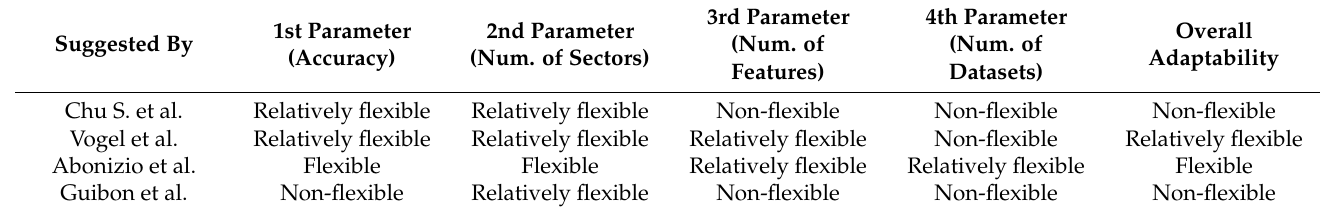
Table 11. Adaptability of Cross-Language